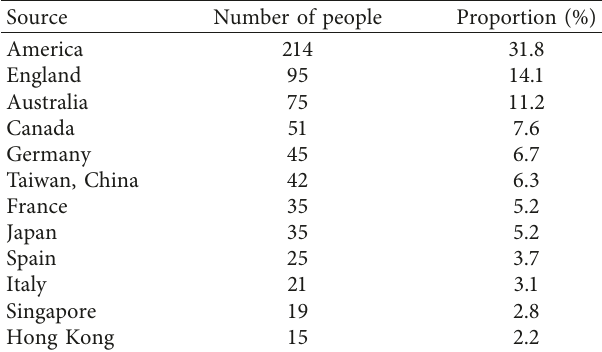
Table 2: Main sources of inbound tourists in